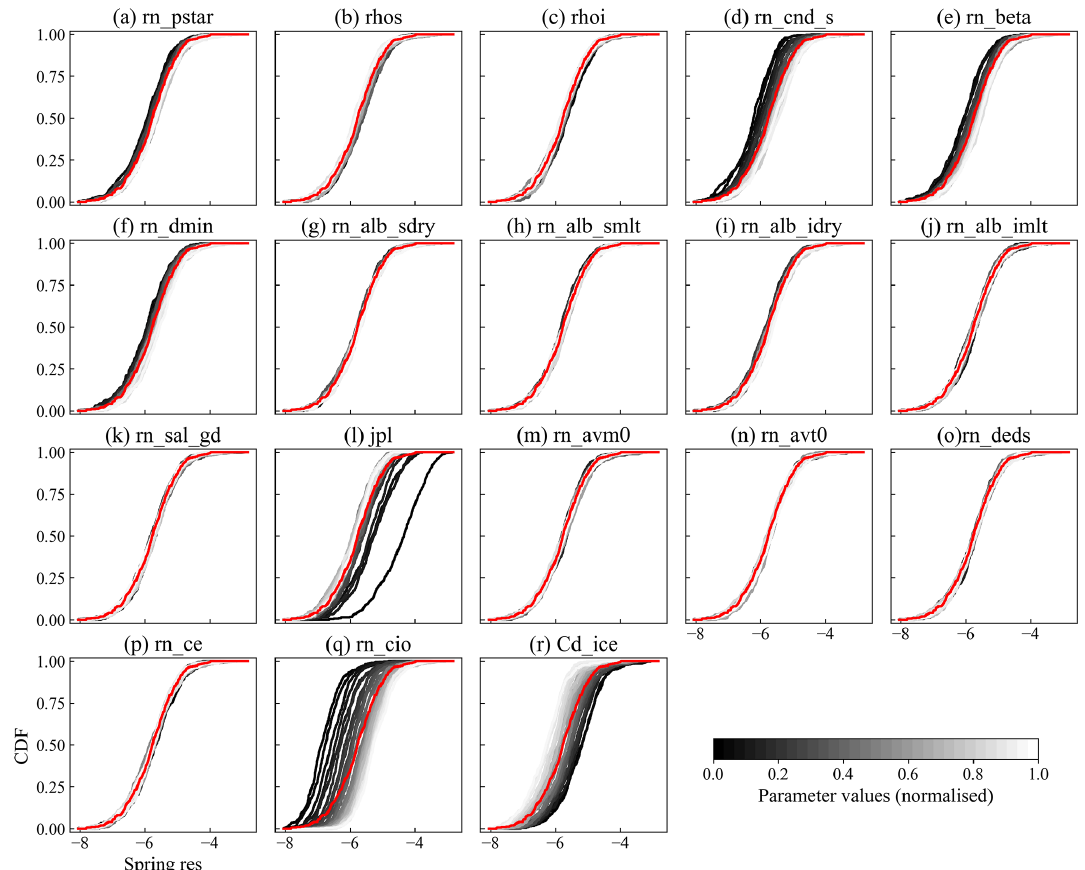
Figure 11. Cumulative distribution function (CDF) of the area integral of the res component in the spring SIC budget (see Fig. 3). Red lines are the unconditional CDF for the ensemble of 449 model runs, and the grey lines stand for conditional CDF at different fixed values of parameters calculated by the GP emulator. The units of the x axis are 10 6 km 2